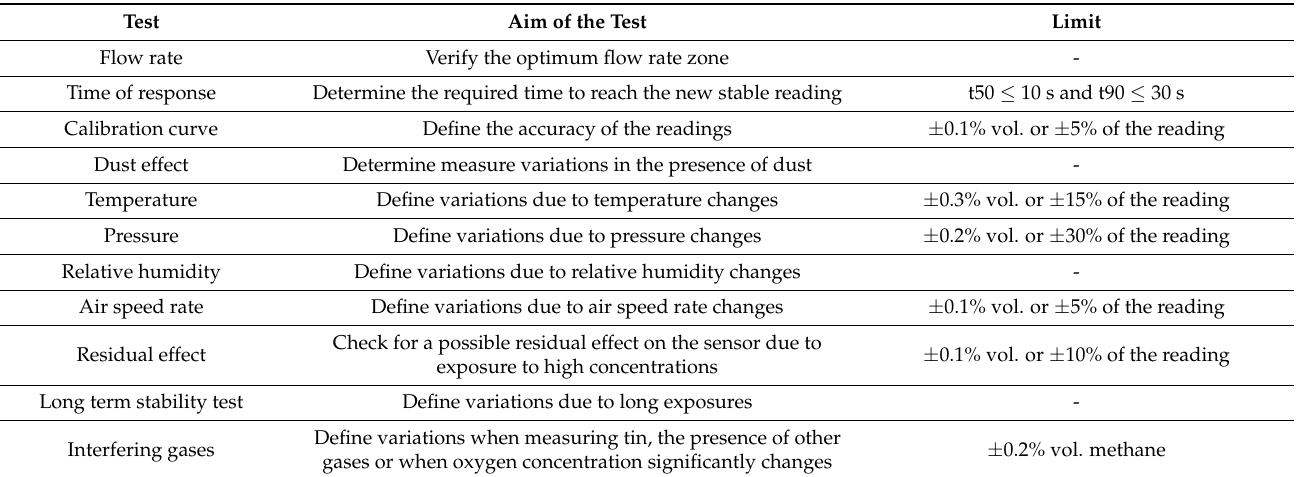
Table 2. Functionality